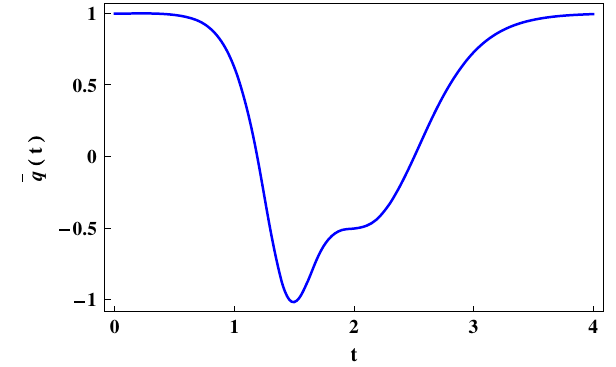
Fig. 10 Acceleration parameter evolution for Model III , with c 0 = 1 . 00015, λ 1 = 2 . 25, λ 2 = 4 . 5, λ 3 = 0 . 00005 and α 3 = − 7 .